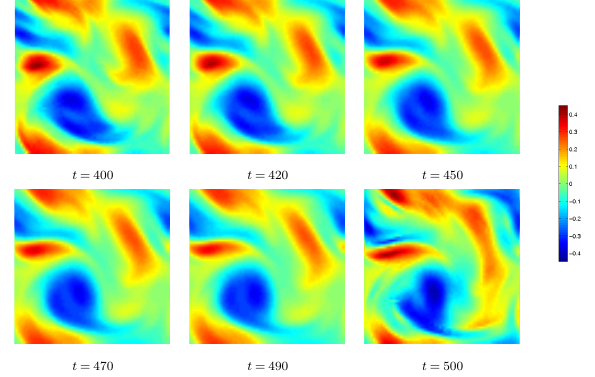
Figure 8. Filtering result with the method of Papadakis et al. (2010). Fig.8: FilteringresultwiththemethodofPapadakisetal.(2010). Estimatedmeanvorticitymapsfordifferent times t betweenobservationtimes t =400 and t =500 . Estimated mean vorticity maps for different times t between obser- vation times t = 400 and t = 500.